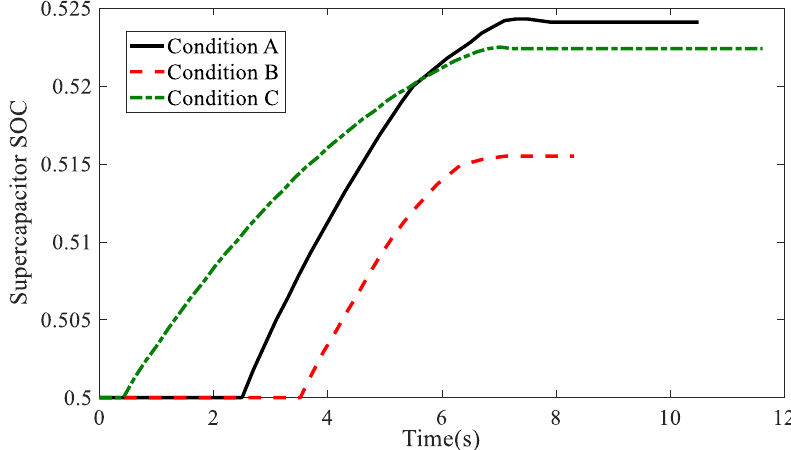
Figure 19. Supercapacitor SOC with time under different conditions.